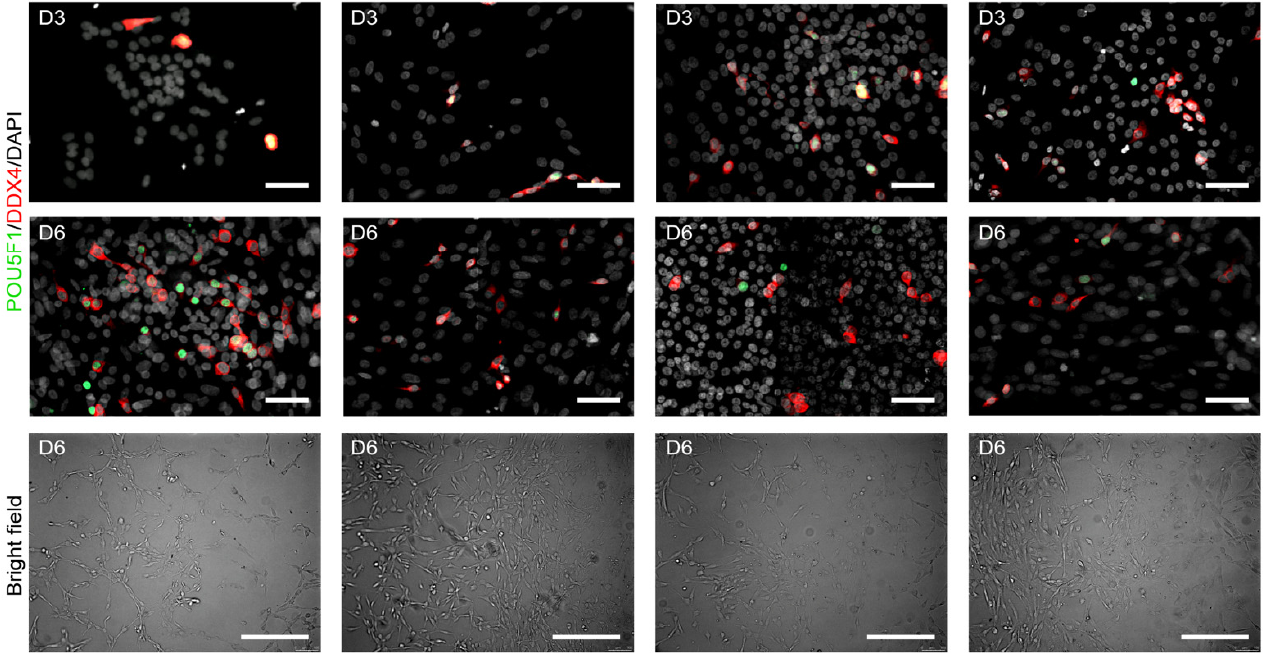
Figure 2. Quantification of hFGCs in Shinohara-medium and different substrates. Quantification of the total number of hFGCs ( n = 3 different donors) per 90,000 µ m 2 and the percentage of different hFGC types (POU5F1+, POU5F1+DDX4+ and DDX4+ cells) grown for 3 and 6 days in gelatin-coated substrate ( A ), laminin-coated substrate ( B ), vitronectin-coated substrate ( C ) and matrigel-coated substrate ( D ). All data are represented as mean ± SEM. Statistical analysis was performed by using the t -test (***, p -value < 0.001; ns, not significant). For immunofluorescence, nuclei were counterstained with DAPI (white). Scale bars: 50 µ m in immunofluorescence images and 300 µ m in bright field